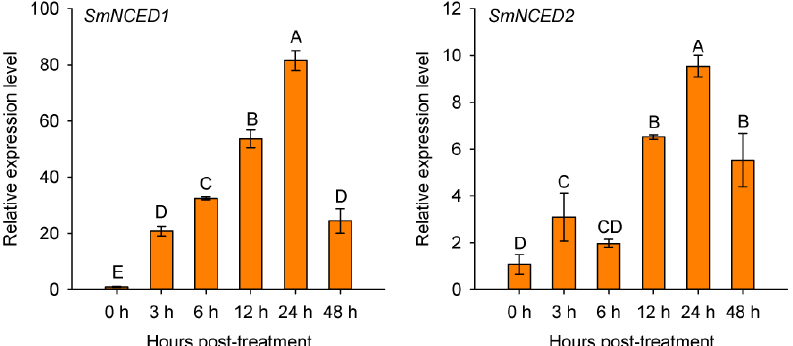
Figure 5. Analysis of the relative transcript expression levels of marker genes related to salt stress responses in eggplant roots under salt stress inferred by a qPCR assay. Data are means ± standard deviation from four biological replicates. Different capital letters between samples denote significant differences according to one ‐ way ANOVA and Tukey’s test ( p < 0.01).